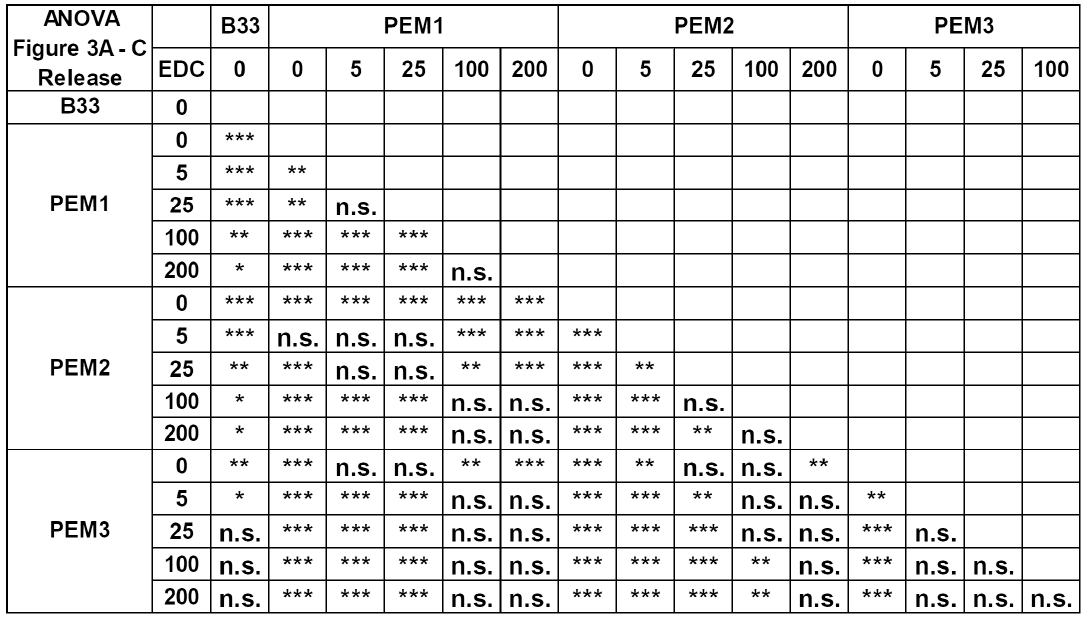
Figure A1. Results of one-way ANOVA for data related to Figure 3A–C; n.s.: not significant; *: p <